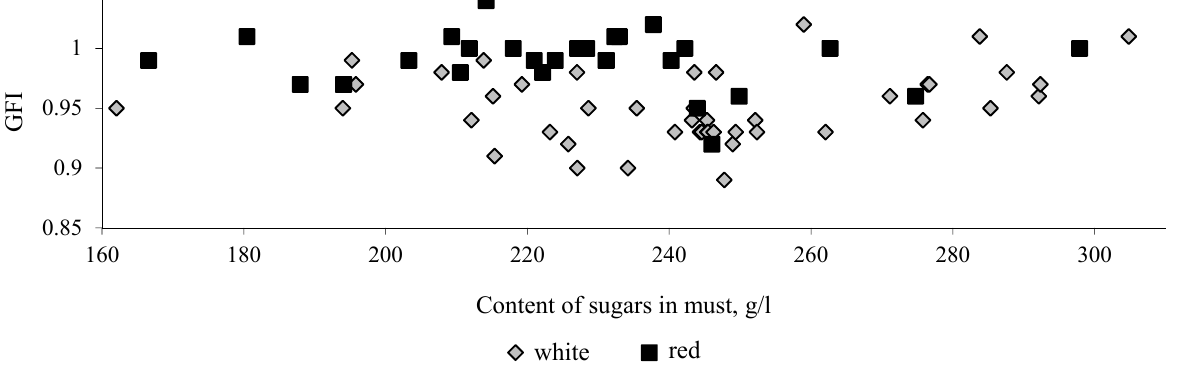
Fig. 1. Glucose-fructose index (GFI) in the must of grapes of white and red varieties (the list of varieties is provided in the methodical